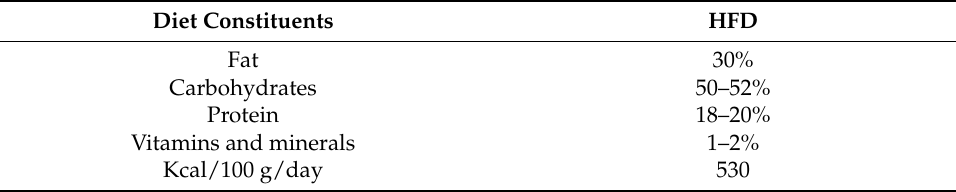
Table 2. Chemical composition of high-fat